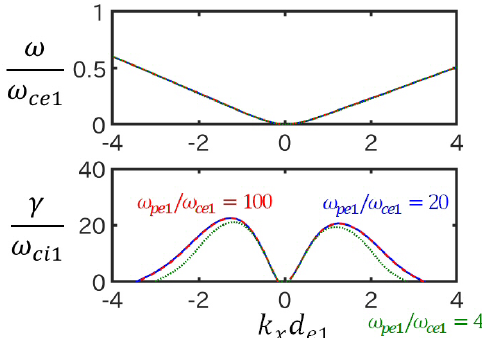
Figure 5. Linear dispersion relations for a three-component plasma based on the velocity distribution functions in the foot region of a perpendicular collisionless shock ( V di1 = 0 . 42 ,V ti1 = 0 . 06 ,ω pi1 = 0 . 052 ,V di2 = − 0 . 32 ,V ti2 = 0 . 05 ,ω pi2 = 0 . 047 ,V de = 0 . 08 ,V te = 1 . 94 ,ω pe = 1 . 75 ,ω ce = 0 . 92) in Run A of Table II in the previous study (Umeda et al., 2012b). The frequency ratio ω pe1 /ω ce1 is changed as 4 (dotted lines), 20 (dashed lines), and 100 (solid lines) by keeping v te1 ω pe1 /cω ce1 constant. The wave-normal angle relative to the ambient magnetic field is 85 ◦ for k x > 0 and 84 ◦ for k x <